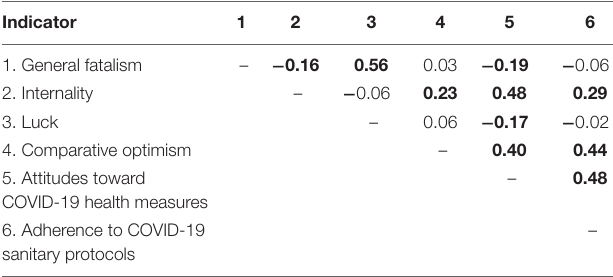
TABLE 2 | Correlations between the study variables.